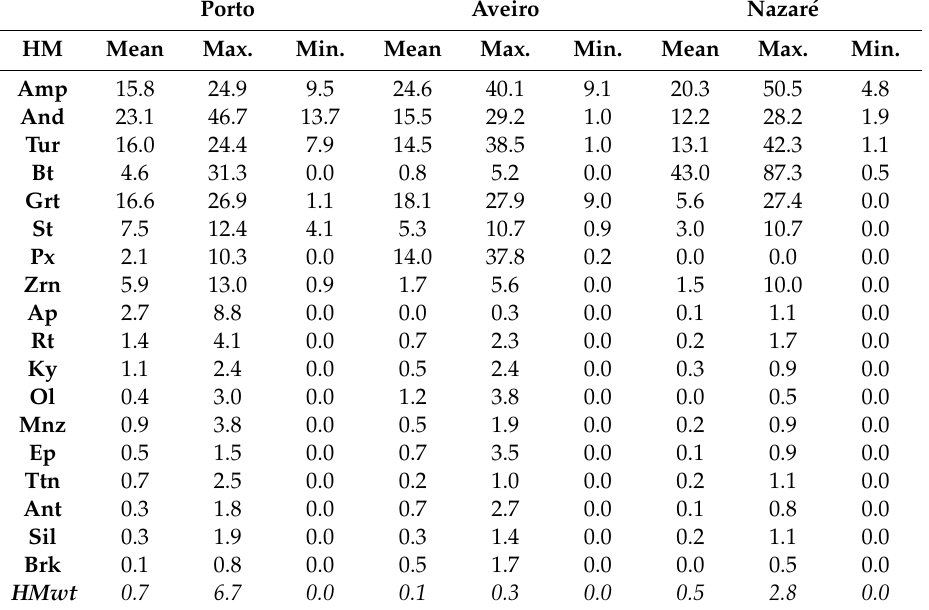
Table 3. Results of the heavy mineral relative frequency for all the analyzed samples (Porto, Aveiro and Nazar é areas) considering the grain size interval between 2 and 4 φ . Mean: mean frequency for each transparent heavy mineral (values in% referred to the total transparent heavy minerals); Max: higher frequency of each transparent heavy mineral; and Min: lower frequency of each transparent heavy mineral. Heavy Minerals (HM): amphibole (Amp), andalusite (And), tourmaline (Tur), biotite (Bt), garnet (Grt), staurolite (St), pyroxene (Px), zircon (Zrn), apatite (Ap), rutile (Rt), kyanite (Ky), olivine (Ol), monazite (Mnz), epidote (Ep), titanite (Ttn), anatase (Ant), silimanite (Sil), and brookite (Brk). HMwt : heavy mineral percentage weighted in the total sample sediment. Porto